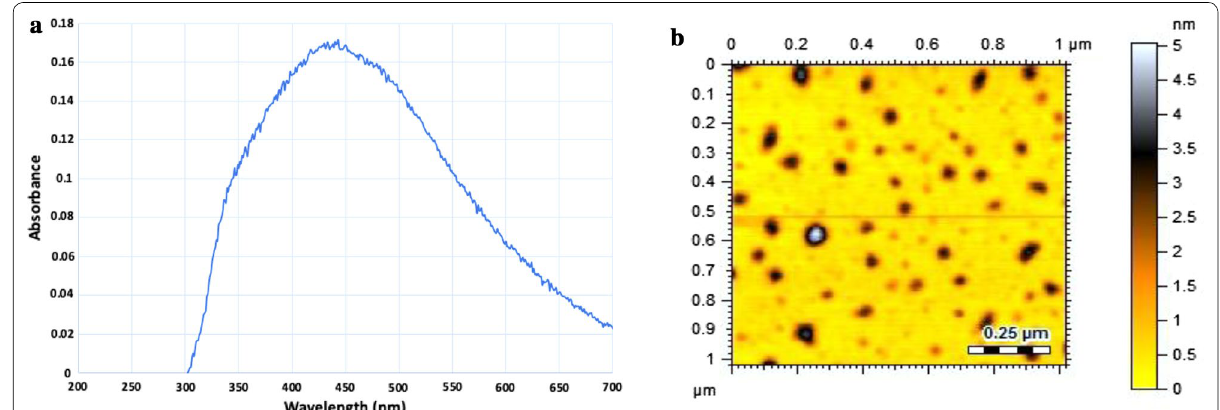
Fig. 2 a UV–Vis spectra of quercetin conjugated silver nanoparticles (QT-AgNPs) showing characteristic surface plasmon resonance band at 443 nm confirming the formation of QT-AgNPs. b AFM topographic image recorded on an AFM